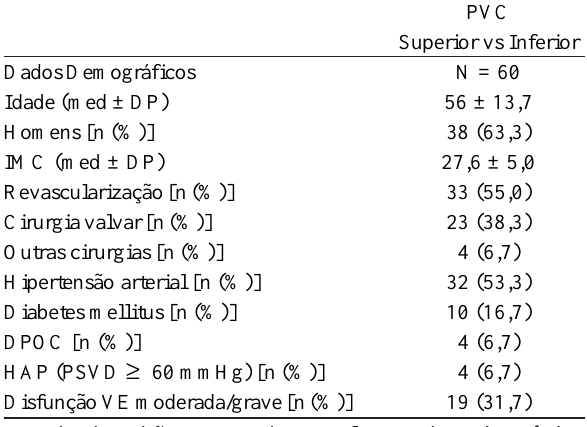
Tabela 1. Dados demográficos